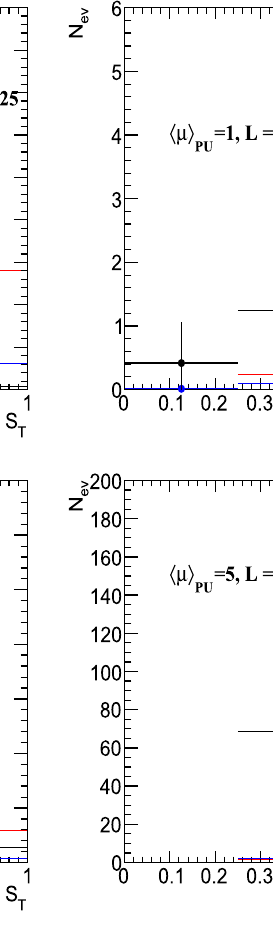
detector-level cuts in Eq. (10) for four luminosity scenarios. Only statis- tical uncertainties are shown, estimated using expected event numbers from Table 1